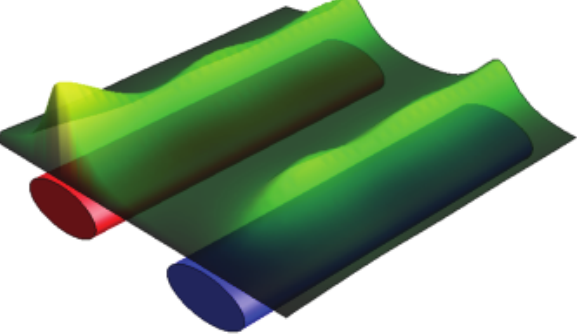
Figure 1. Schematic showing the renormalized light intensity arising from the spontaneous generation of photons through two coupled waveguides in the gain-loss